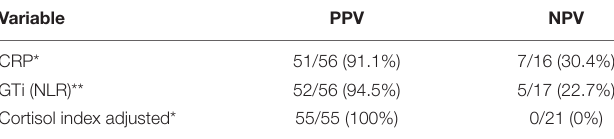
TABLE 2 | Logistic regression of indicators of inflammation.